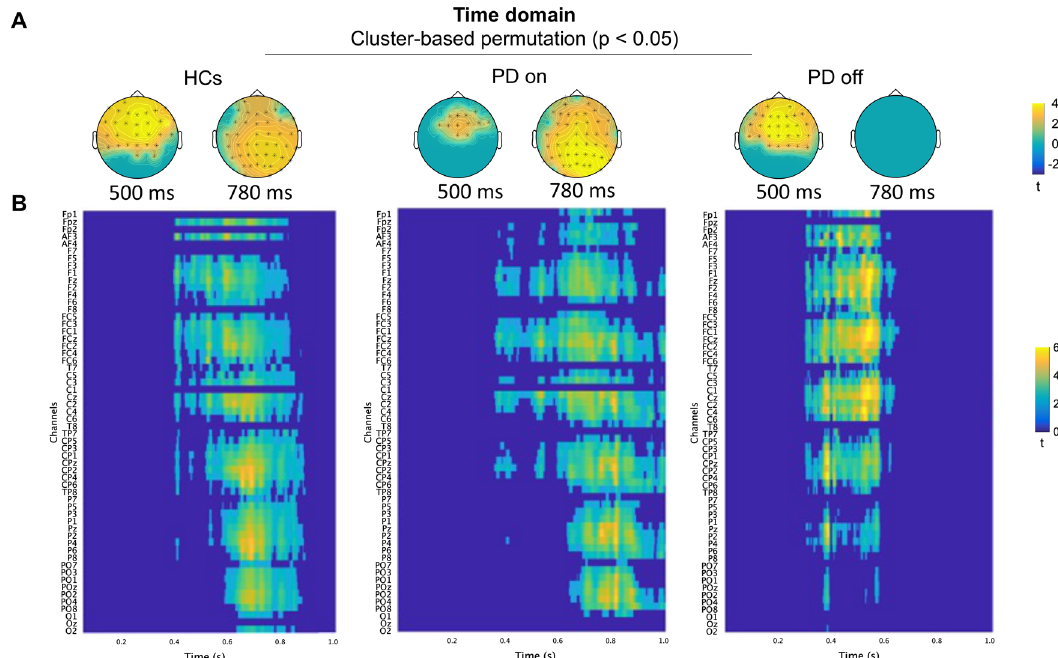
Fig. 1 Cluster-based permutations in the time domain for each group. A Scalp representation of the cluster-based permutations (dependent sample t -tests with cluster-correction p < 0.05) of incorrect vs correct action extracted at two representative time points inside the window of interest. B Channel ( y -axis) vs time ( x -axis) representation of the cluster-based permutation for incorrect vs correct actions in the three groups; 0 ms corresponds to the avatar ’ s arm-path deviation, and the movements end at ~300 ms. For a larger visualisation of ( B ), please see https://osf.io/z9rbu/ fi les/osfstorage (Figures